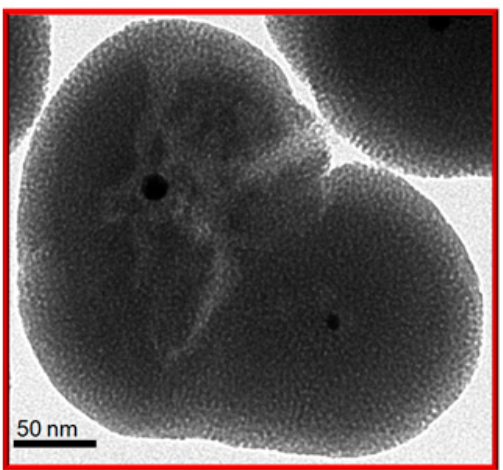
Figure 5. Selective plasmonic photodegradation based on the gold core diameter displayed by a unique TEM image of Au@MSN (7 h of irradiation; 514 nm; 30 mW). TEM image of Au@MSN (7 h of irradiation; 514 nm; 30